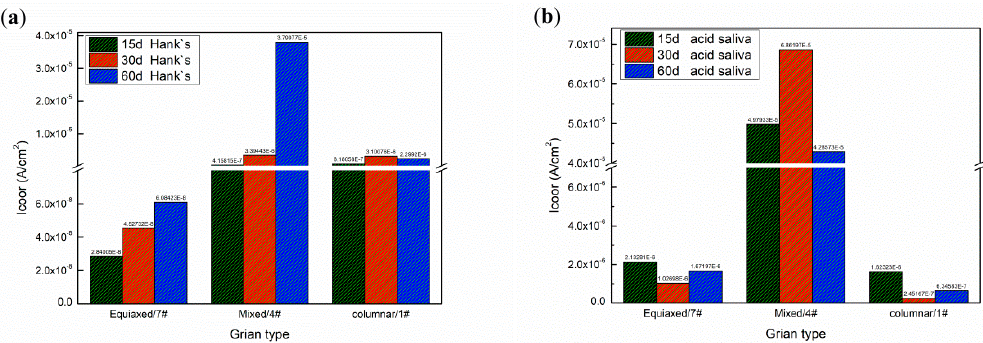
Figure 9. The corrosion current of deposited specimens with different immersion time ( a ) Hank’s solution; ( b ) Acidic saliva.